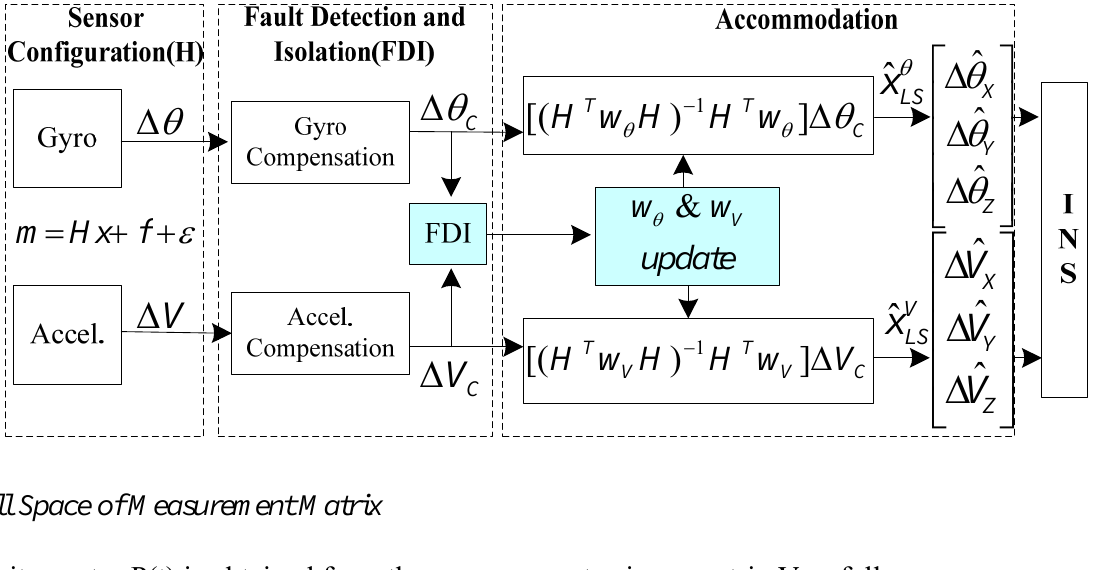
Figure 1. INS with redundant inertial sensor configuration and